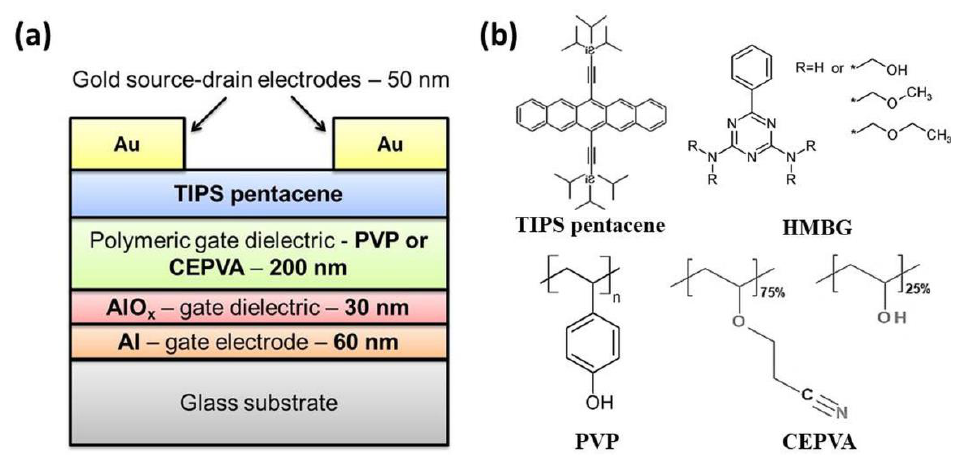
Figure 1. Scheme of the multilayer structure of the prepared organic field effect transistors (OFETs) ( a ) and chemical structure of used compounds ( b ).